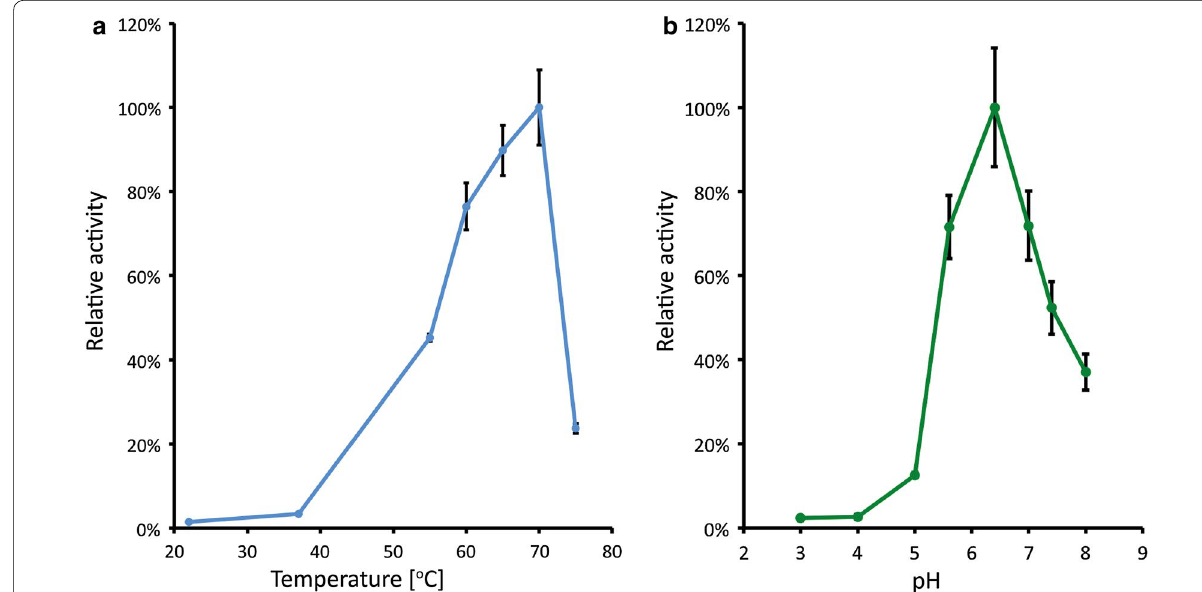
Fig. 1 Temperature ( a ) and pH ( b ) profiles of the BgaB expressed in E. coli . The Y-axis designates the relative β-galactosidase activity at different conditions temperature ( a ) and pH ( b ). Error bars indicate standard deviation calculated based on triplicate experiments. pH profile was assessed at 70